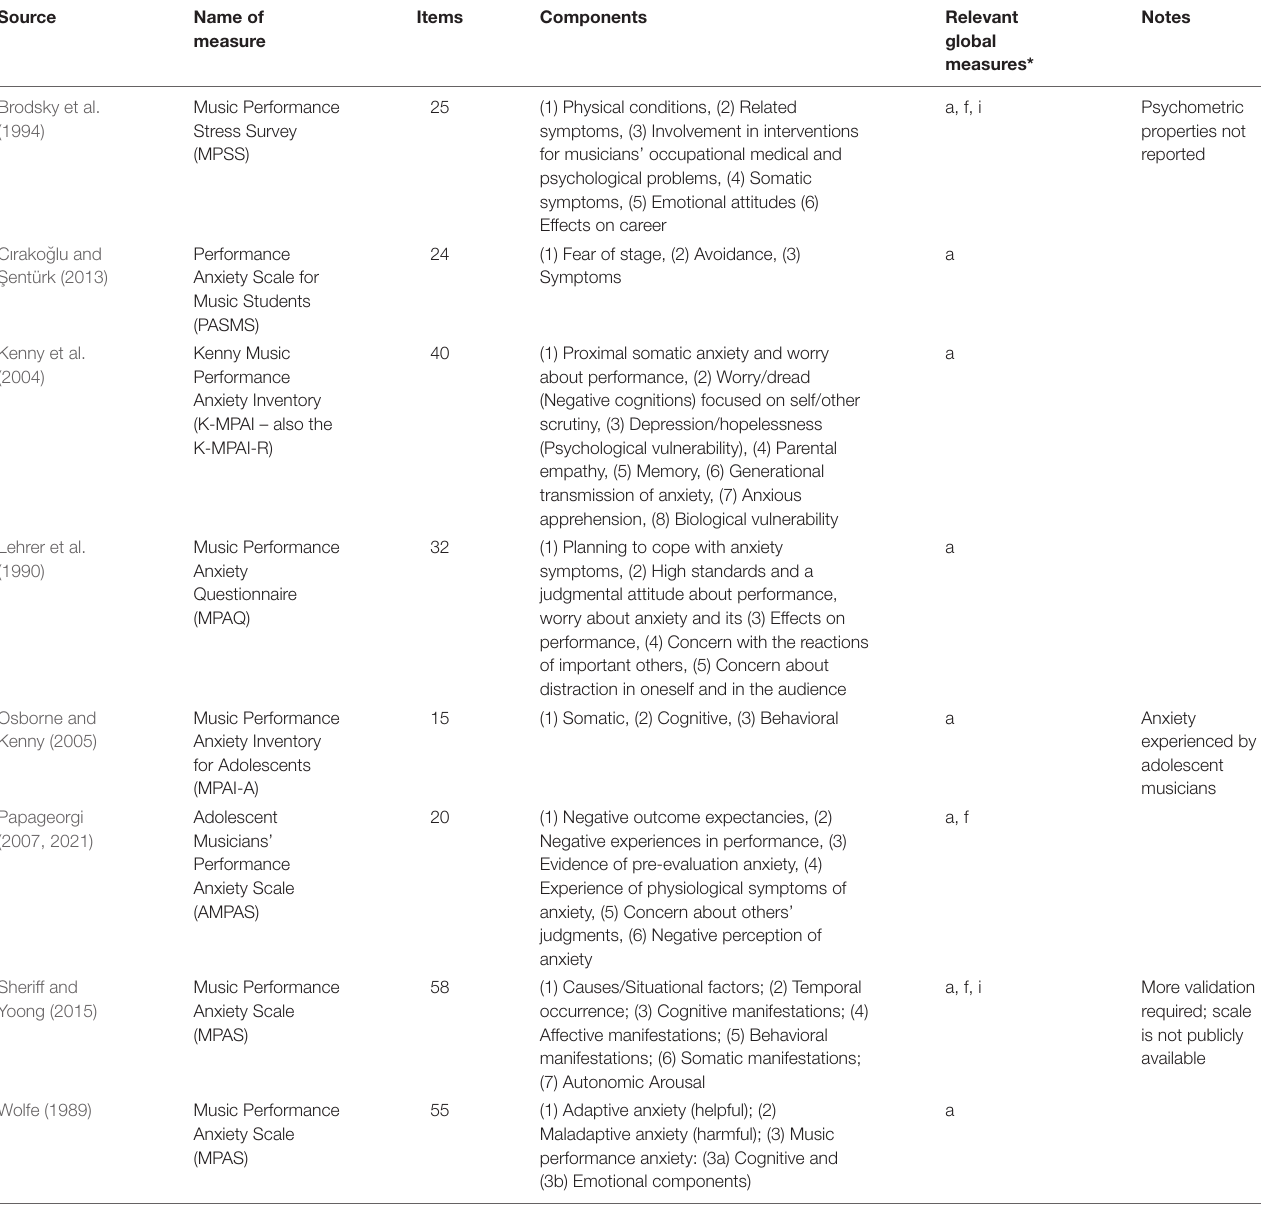
TABLE 1 | Sample of commonly cited, published MPA